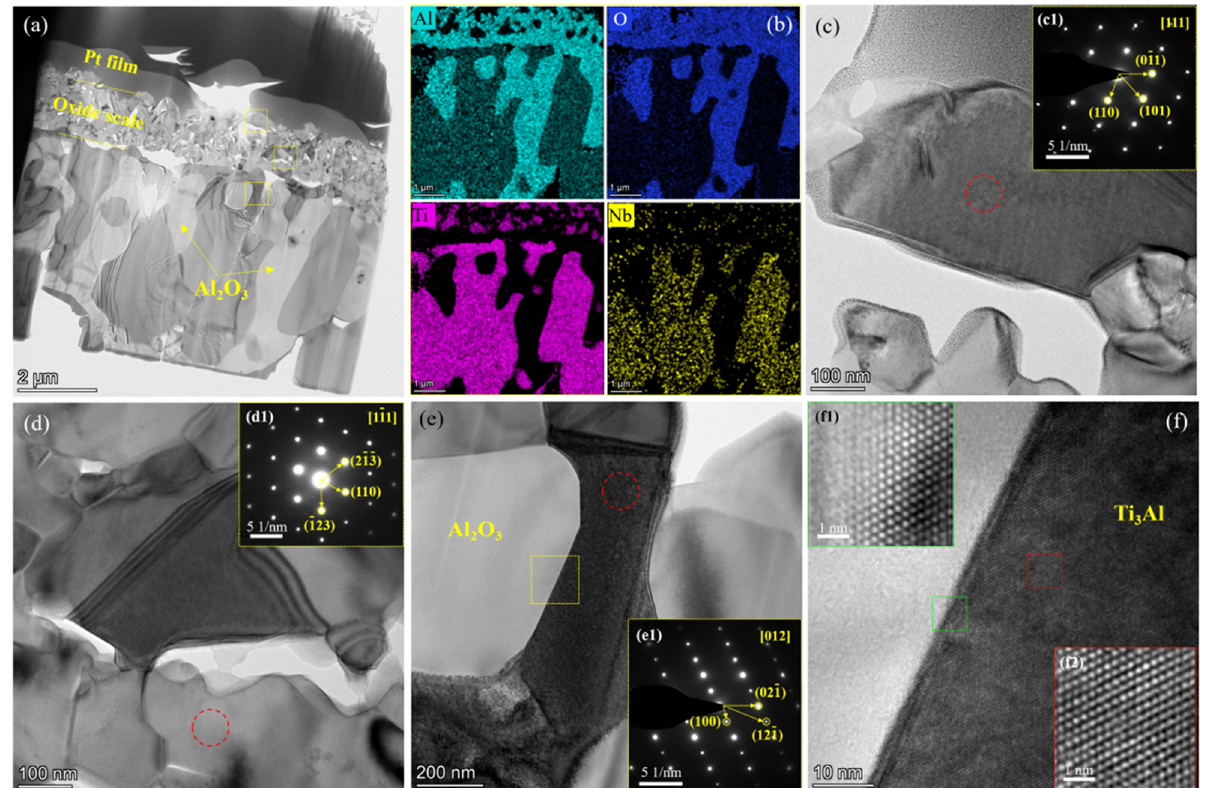
Figure 8. ( a ) TEM image of oxide scale which was selected near the defect of the fluorine ‐ treated specimen with the artificial defect after oxidation at 1000 °C for 100 h, ( b ) the corresponding chem ‐ ical elements distribution of STEM images. ( c – f ) The marked local regions in ( a ) by yellow square examined at high magnification. The red circle region examined by SAED pattern including ( c1 – f1 ). The yellow square region in ( e ) investigated by HRTEM in ( f ). The green square (f1) and red square regions (f2) in ( f ) examined by inverse FFT